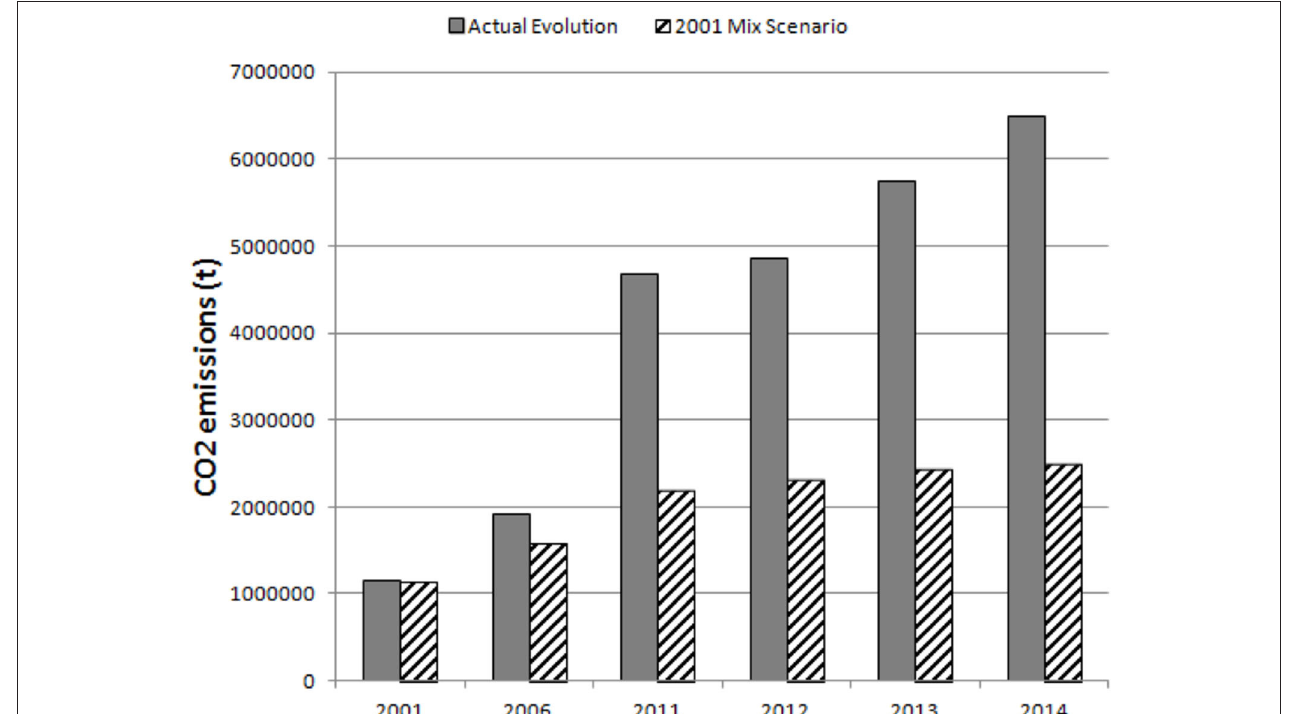
FIGURE 6 | Comparison of CO 2 equivalent emissions considering different electricity generation mix.